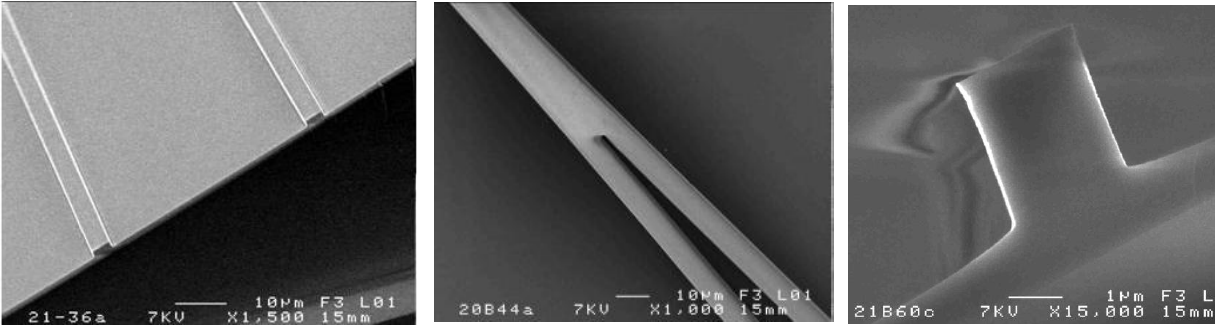
Sb S deposited by sputtering . 25 10 65